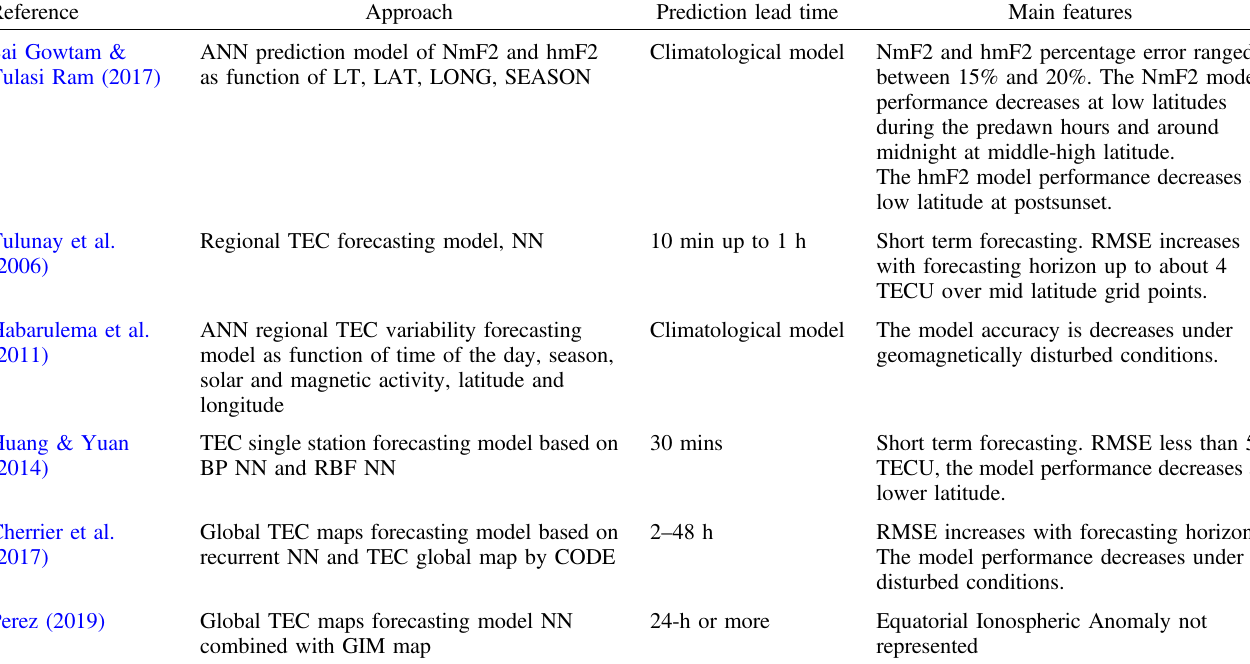
Table 1. Summary of the described ionospheric parameters forecasting based on